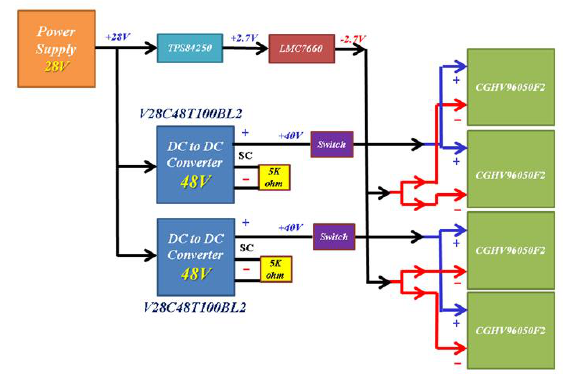
Figure 12: Block diagram of the DC